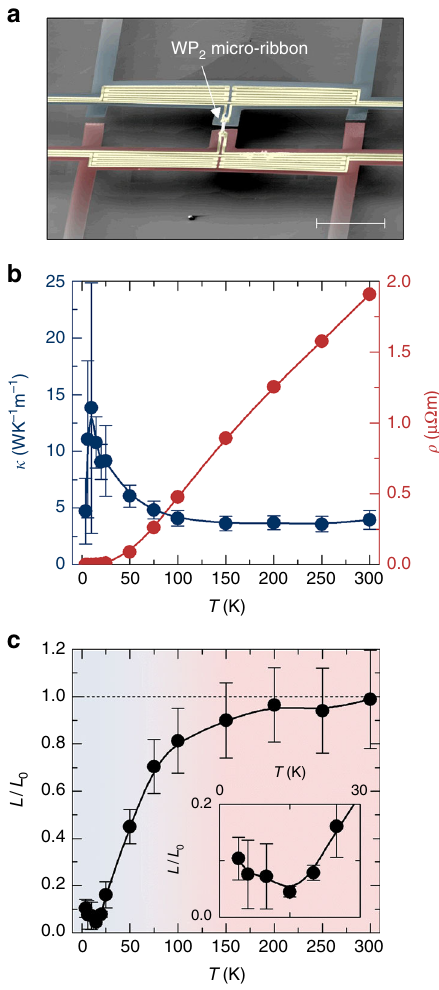
Fig. 2 Violation of the Wiedemann – Franz law. a False-colored SEM image of a microdevice for measuring thermal transport that consist of two suspended platforms bridged by a 2.5- μ m-wide WP 2 ribbon. The scale bar denotes 100 μ m. b Thermal conductivity κ (left axis) and electrical resistivity ρ (right axis) of the micro-ribbon as a function of temperature. The error bars denote the error of the measurement as described in the Supporting Information. c Lorenz number L = κ T ρ , calculated from the data in b in units of the Sommerfeld value L 0 . The error bars denote the error, coming from the thermal conductivity measurements. The inset shows a zoom of the low-temperature